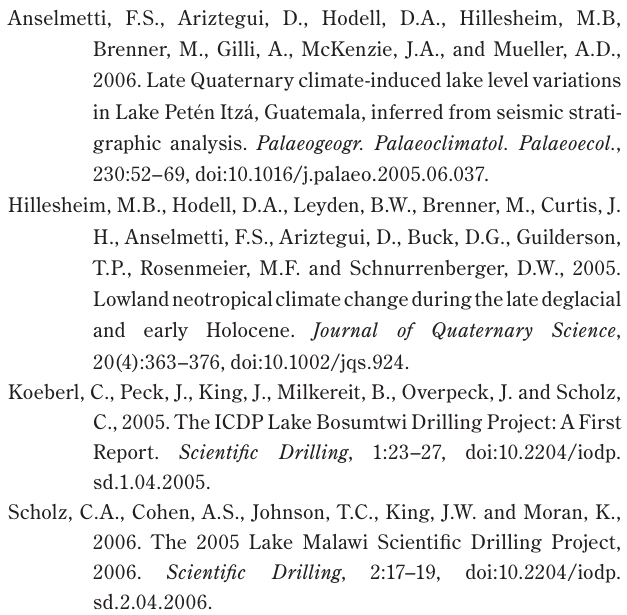
Fig. 1: from NASA, Visible Earth (http://veimages.gsfc. Fig. 3: illustration from Andreas Mueller.